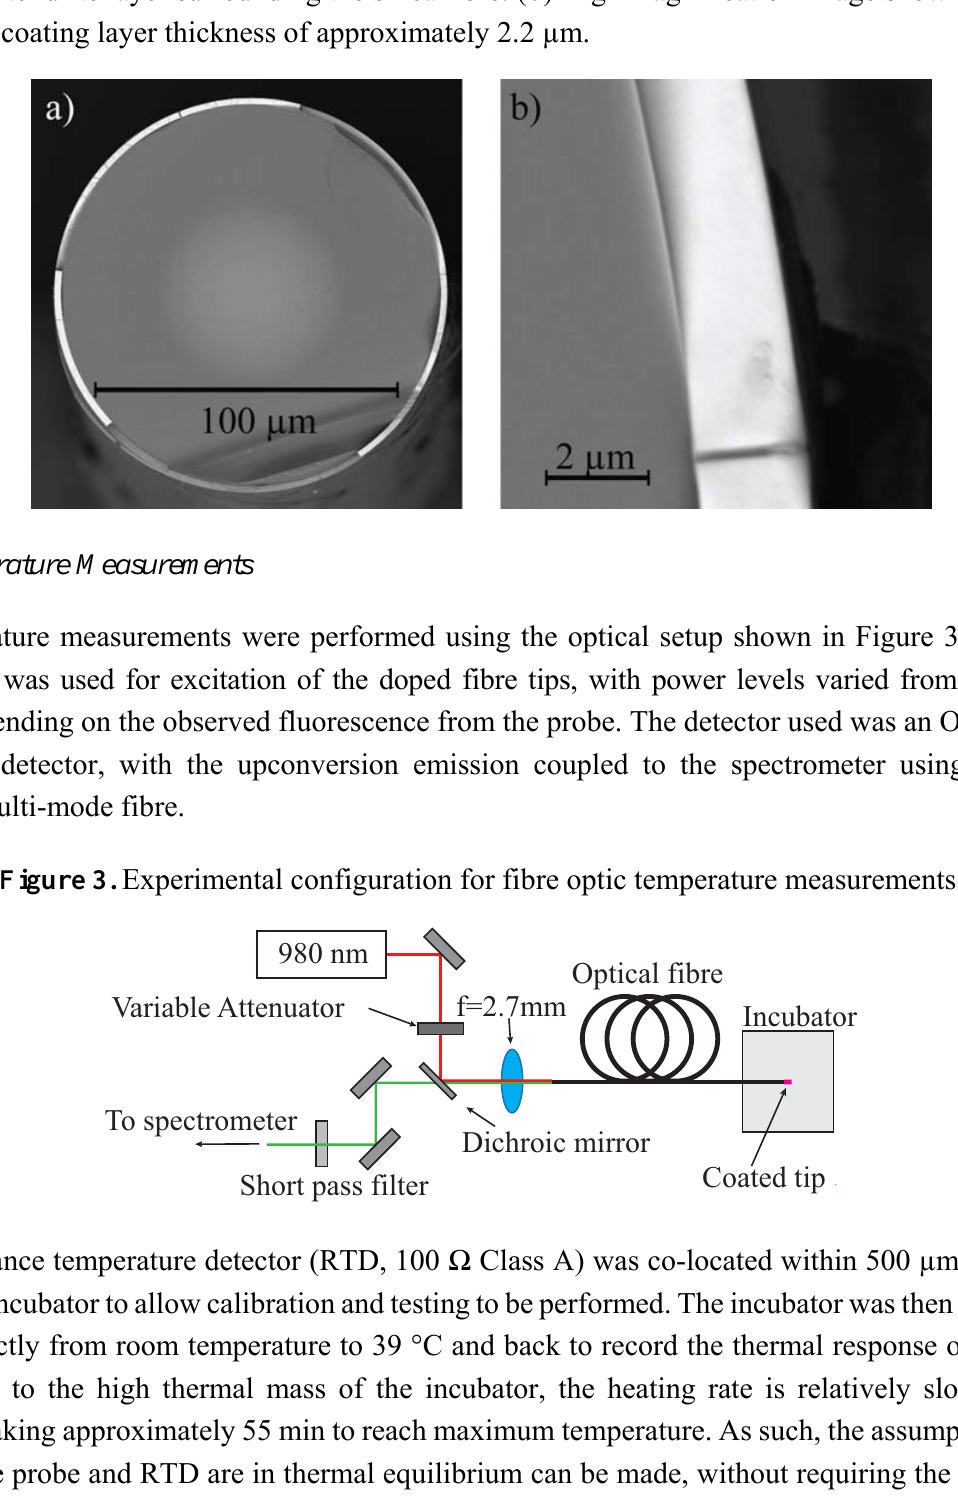
Figure 2. ( a ) SEM image of a Er Yb coated multi-mode fibre, cleaved to show the higher